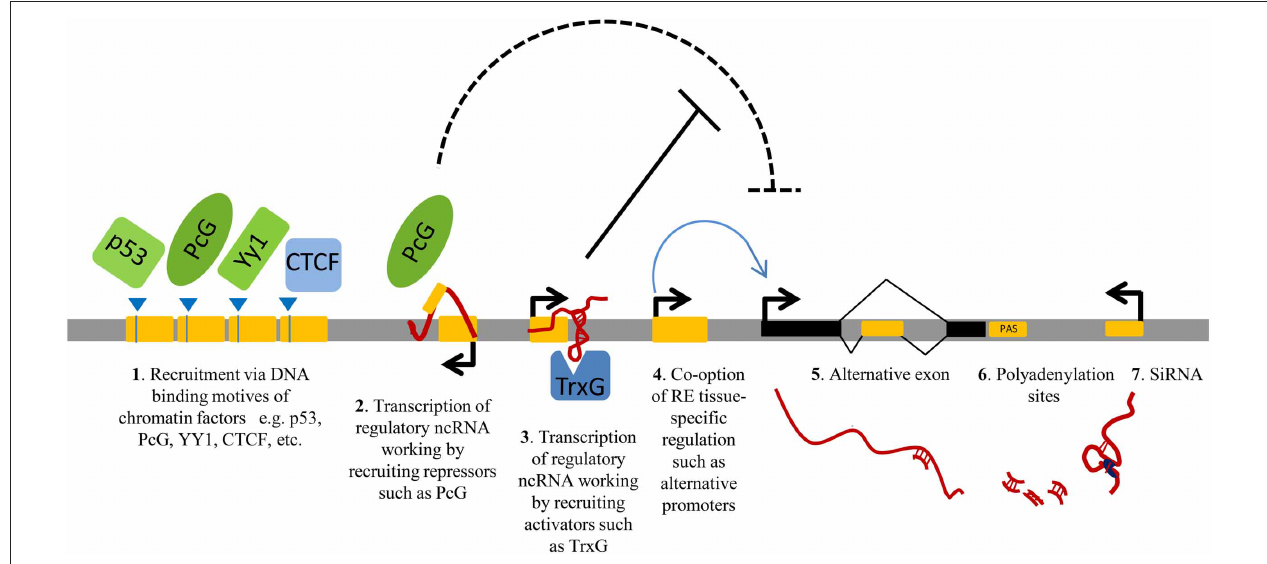
FIGURE 1 | A schematic view of the principal gene-regulatory functions of repeats. Repetitive elements (RE, represented as yellow modules) have an impact on gene expression by providing DNA binding sites for transcription factors or chromatin regulators (1) ; upon transcription, by generating regulatory non-protein-coding RNAs (ncRNAs) involved in gene silencing (2) or gene activation (3) , for example via